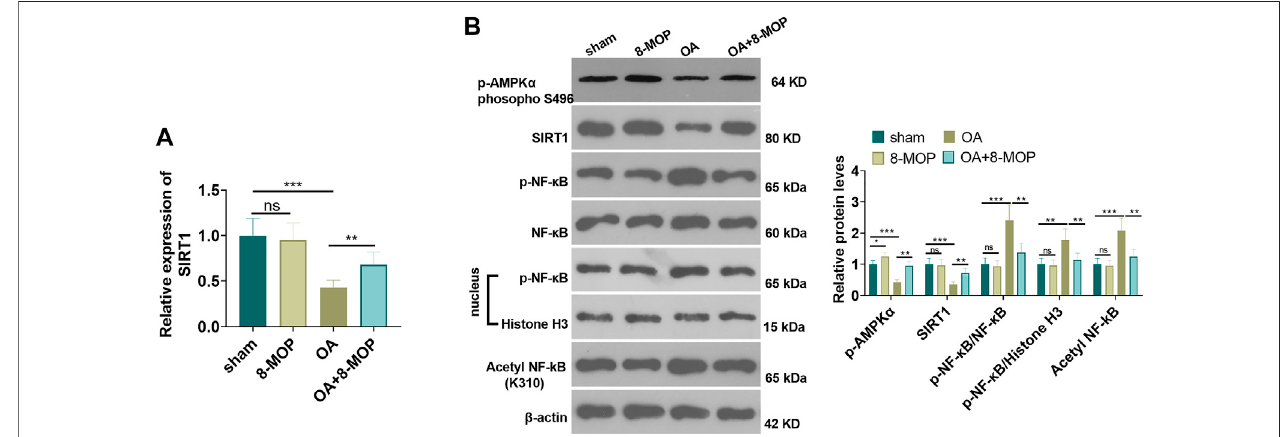
FIGURE 7 | 8-MOP facilitated the expression of the SIRT1/NF- κ B pathway in OA rats. The Wistar rat OA model was established by intraarticular injection of 4% papain.Ratsweredividedintofourgroups:Theshamgroup,the8-MOP(30 μ mol/kg,i.p.)group,theOAgroup,andtheOA+8-MOP(30 μ mol/kg,i.p.)group. (A) .qRT- PCR was used for evaluating SIRT1 mRNA. (B) . The expression of p -AMPK α , SIRT1 and p-NF- κ B p65 protein levels and acetylation NF- κ B p65 was determined by Western blot. ns p > 0.05, * p < 0.05, ** p < 0.01, *** p < 0.001. ( n (cid:1)